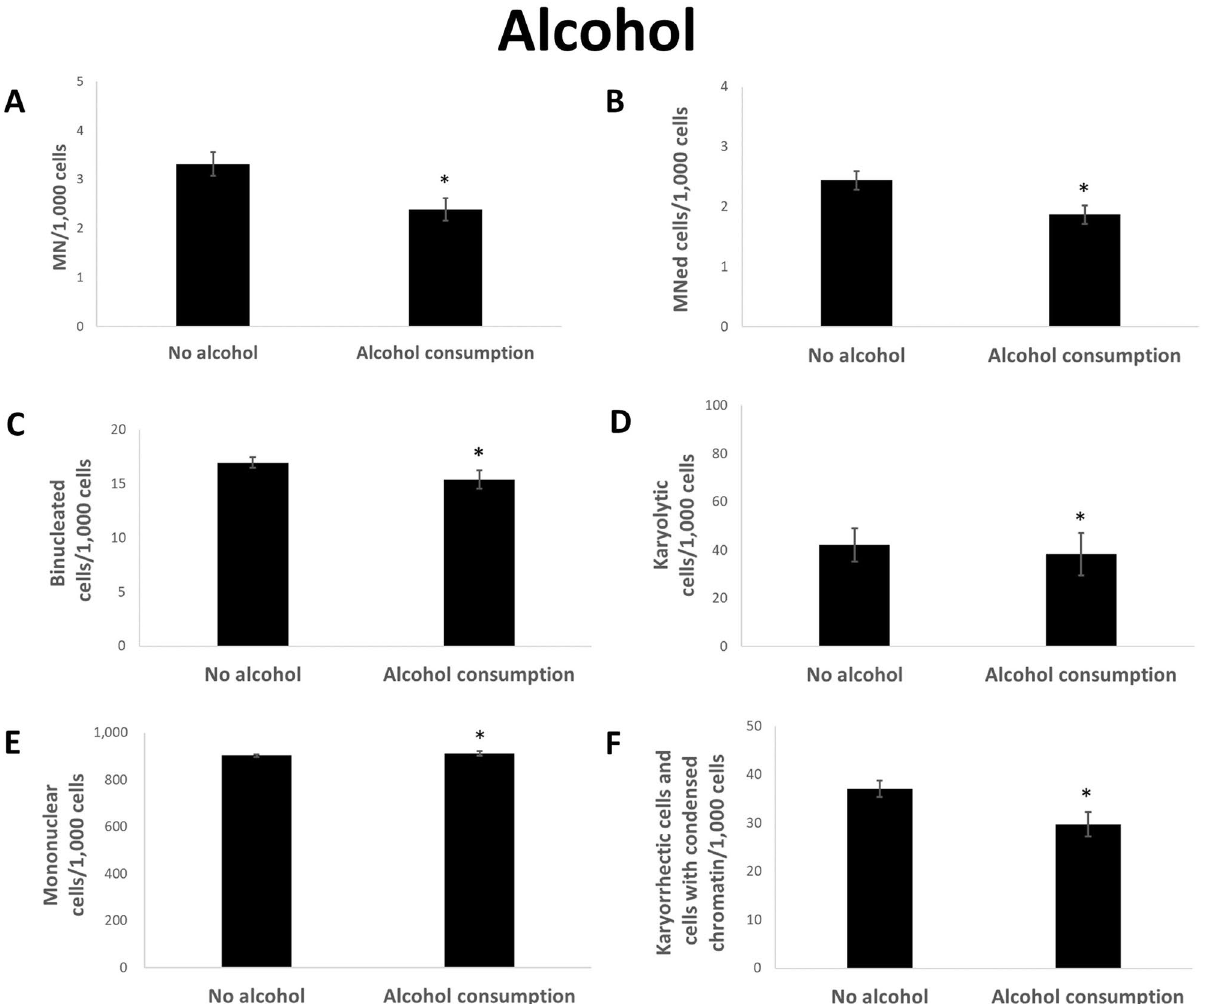
Figure 4. Rate of MN ( A ), Mned cells ( B ), binucleated cells ( C ), karyolytic ( D ), mononuclear ( E ) and karyorrhectic cells and cells with condensed chromatin ( F ) per 1000 cells from reference distributed by alcohol consumption. Mean of each group ± standard error. n (no-alcohol): 214; n (alcohol consumption): 113. Asterisk represent p value < 0.05 after statistical evaluation referring to non-alcohol consuming